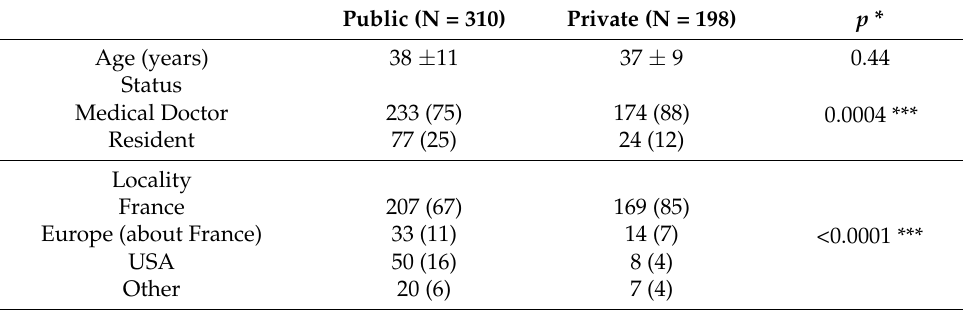
Table A1. Public versus private practice